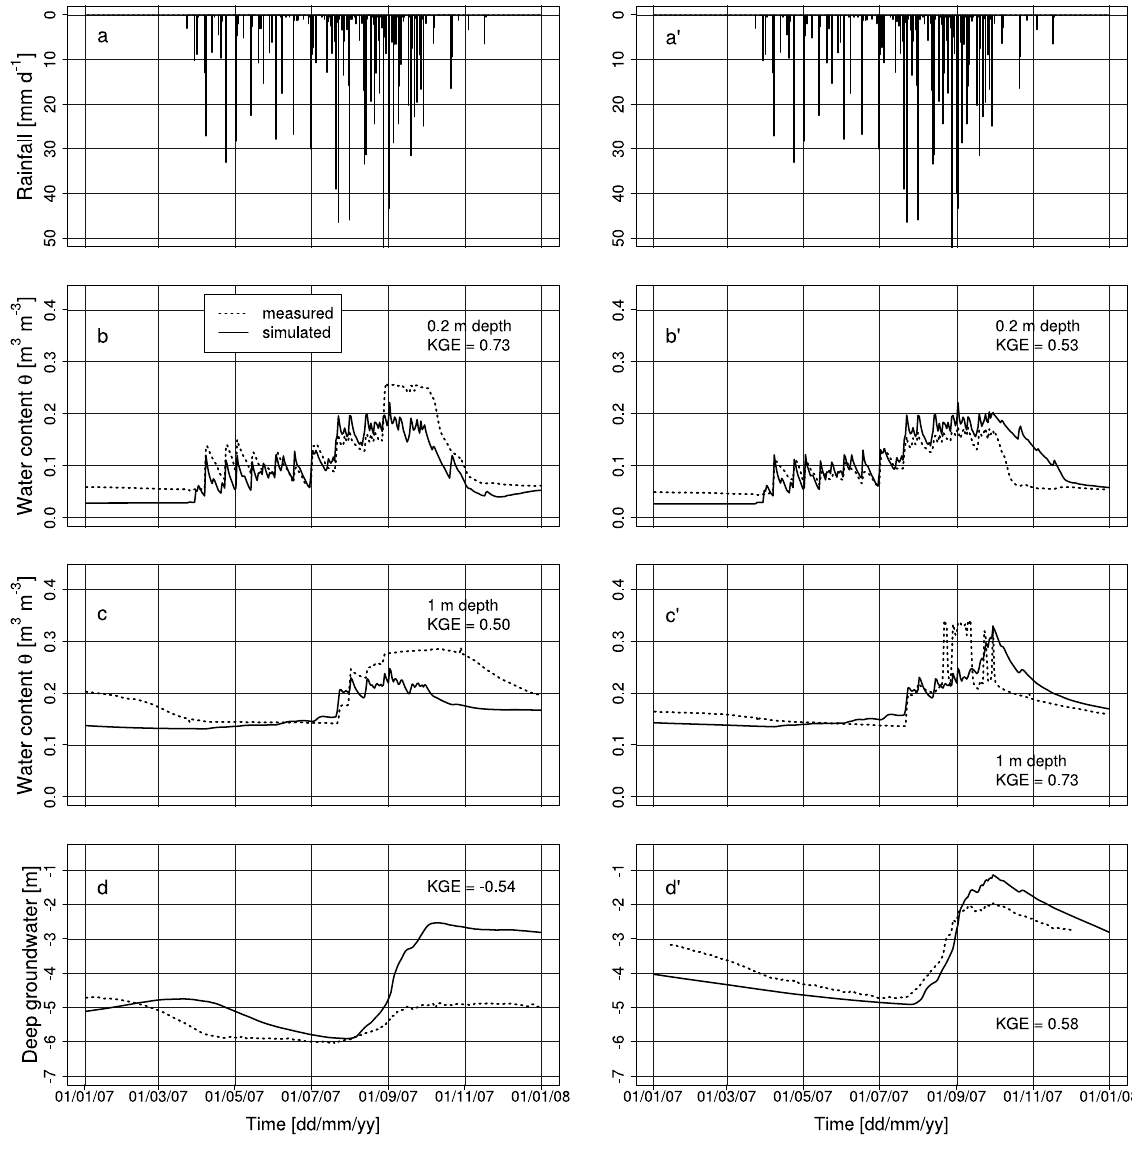
Fig. 9. Forcing variable (rainfall) and state variables of Hydrus 2-D for the 2007 simulation. Graphs on the left are for the bottom of the hillslope; graphs on the right are for the middle of the hillslope. (a, a’) measured rainfall; (b, b’) measured and simulated water content at 0.2m depth; (c, c’) measured and simulated water content at 1m depth; (d, d’) measured and simulated groundwater table